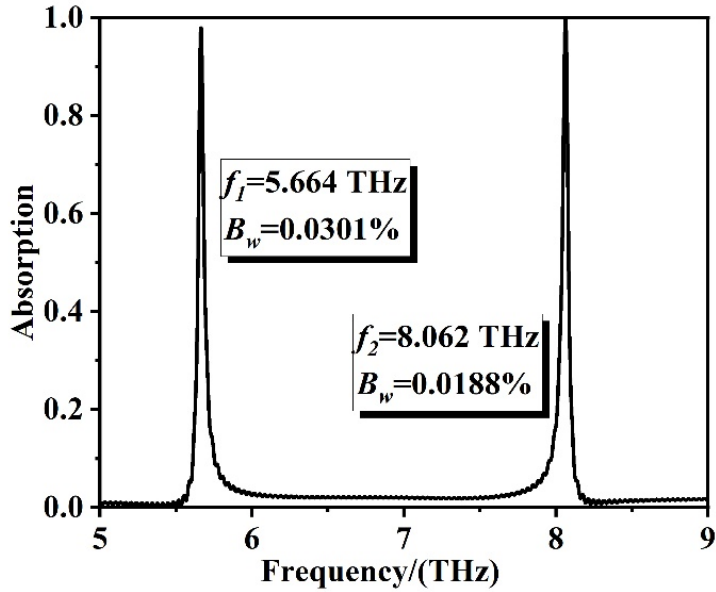
Figure 2. Absorption spectra of ultra-narrow graphene absorber in the range of 5~9 THz with resonance frequency f and absorption bandwidth B w marked on the graph.